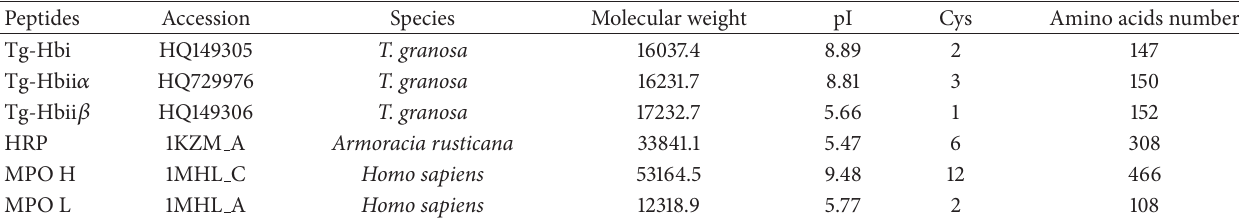
Table 2: Basic biochemical properties of Tg-Hb, MPO, and HRP.